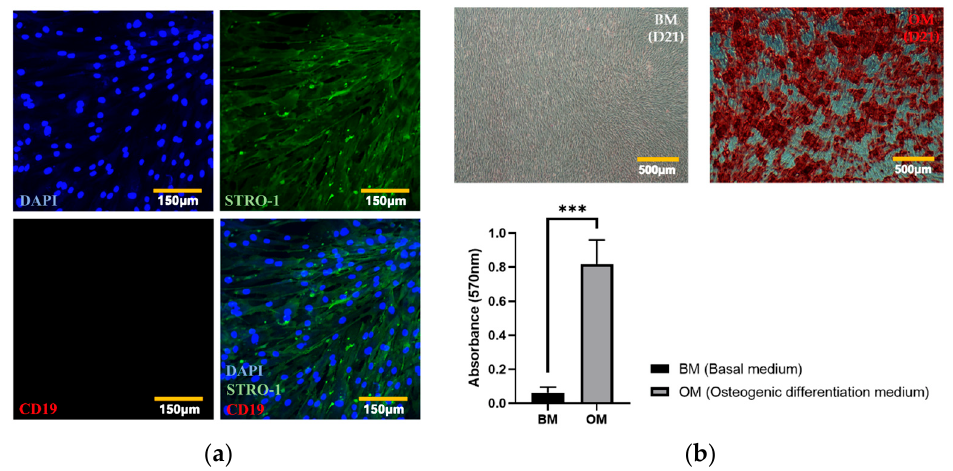
Figure 2. Characterization of mesenchymal stem cells. ( a ) Expressions of positive and negative markers were visualized using a confocal microscope, and the nuclei were counterstained with DAPI (STRO-1 (positive marker), CD19 (negative marker)). ( b ) ARS staining assay for mineralization quantified using the CPC method ( t -test, *** p < 0.001).